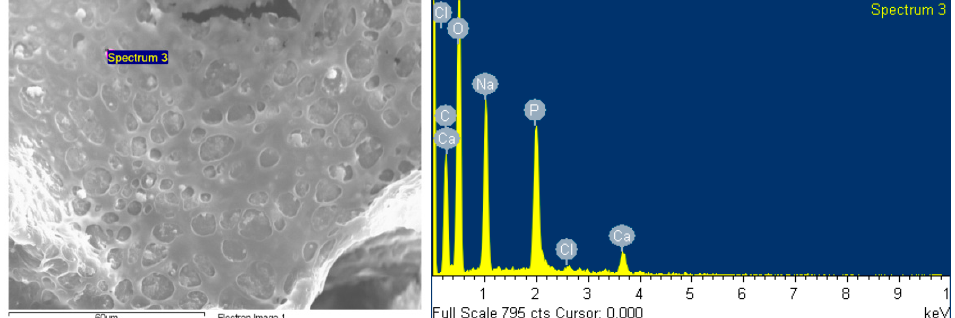
Figure 8. Energy dispersive X-ray spectroscopy result obtained on 7F2 osteoblast-seeded polyurethane composite filler.